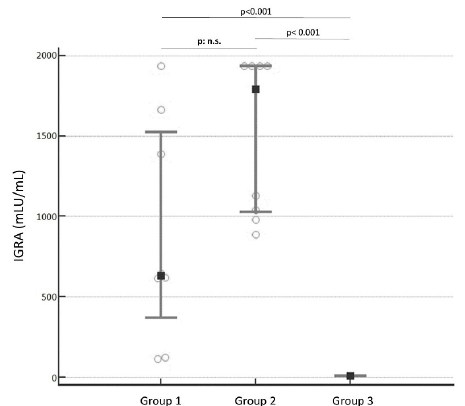
Figure 2. The IGRA concentration between the three groups. It was no noted significant difference between Group 1 and Group 2 ( p : not significant, n.s.). Group 3 is significantly different from Group 1 ( p < 0.001) and Group 2 ( p < 0.001).